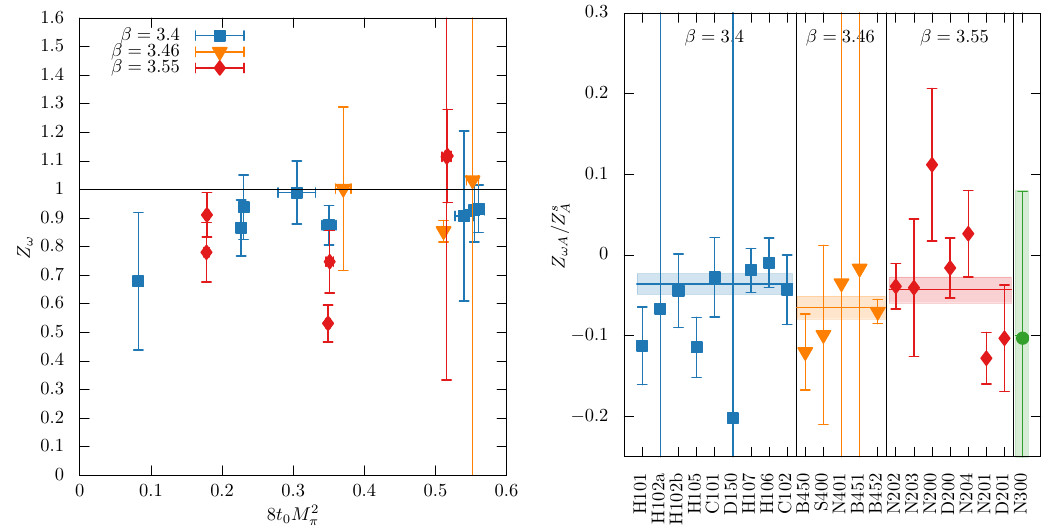
Figure 10. (Left) Z ω from solving eq. (6.30). The m s = m ‘ points are not shown since in these cases F 0 η = 0 and the equation system is singular. (Right) Values of Z ωA /Z s assuming Z ω = 1 .